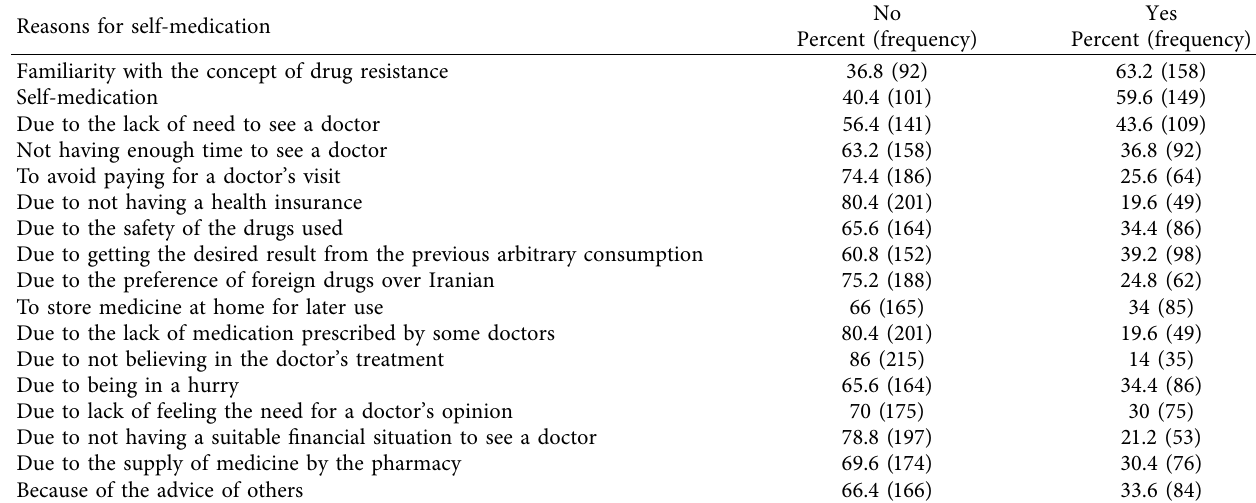
Table 2: Distribution of relative and absolute frequency of arbitrary drug consumption in research units.